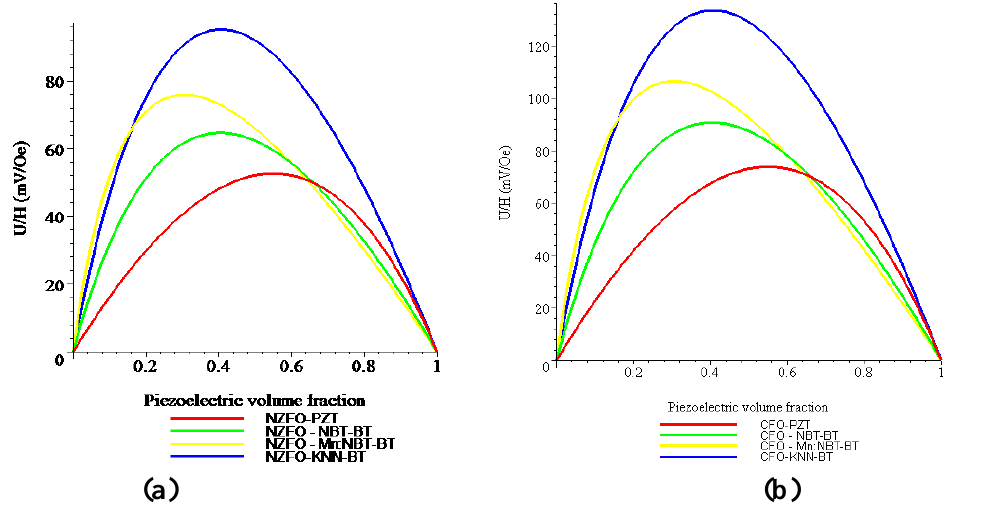
Figure 9. Piezoelectric volume fraction dependence of transverse ME voltage coefficient for bilayers of NZFO and piezoelectrics (a) and CFO and piezoelectrics (b) .